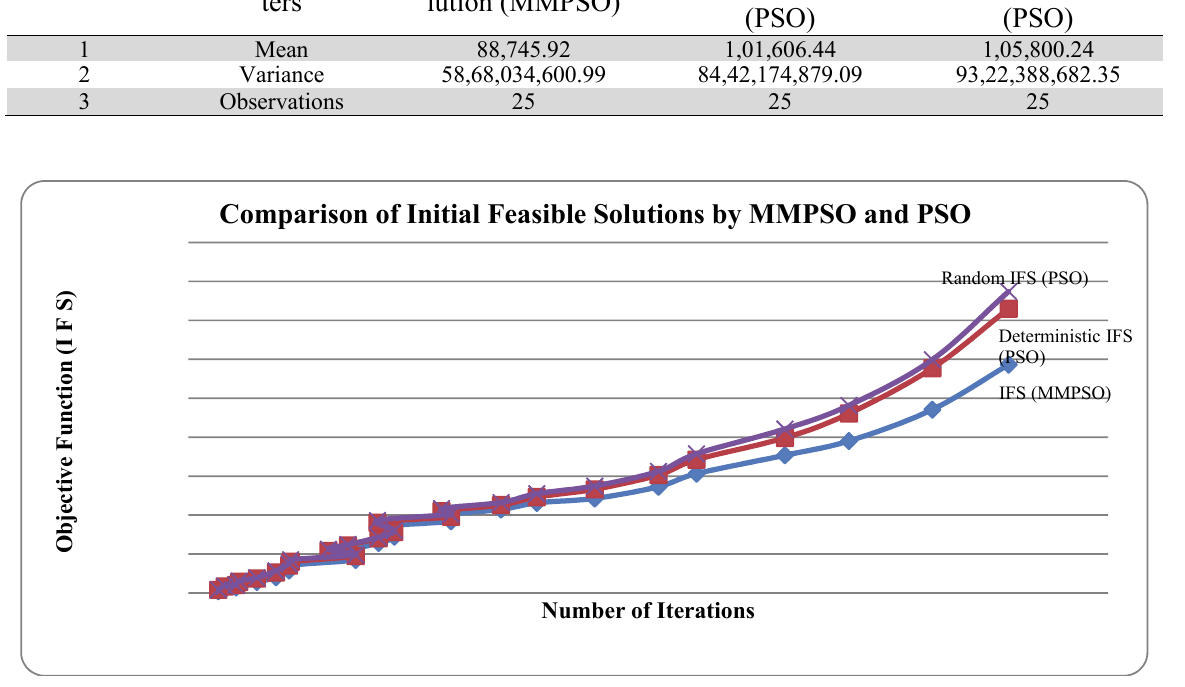
Mean and Variance of Initial Feasible Solution alternatives PSO and MMPSO (Deterministic; Random) S No.